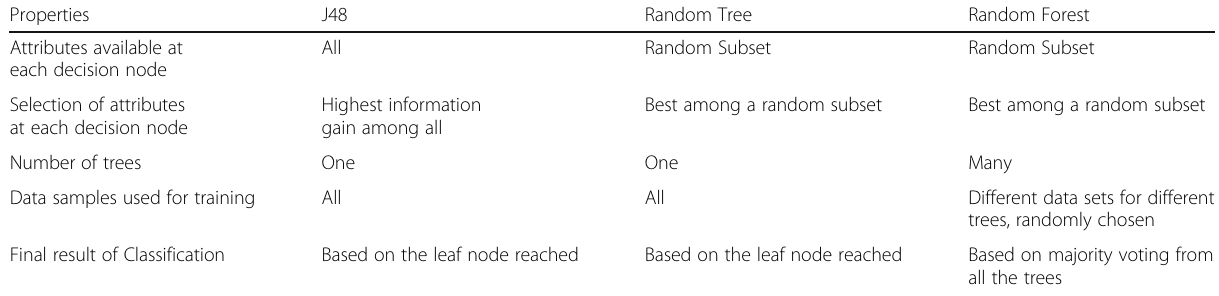
Table 1 Differences between Data Mining Algorithms